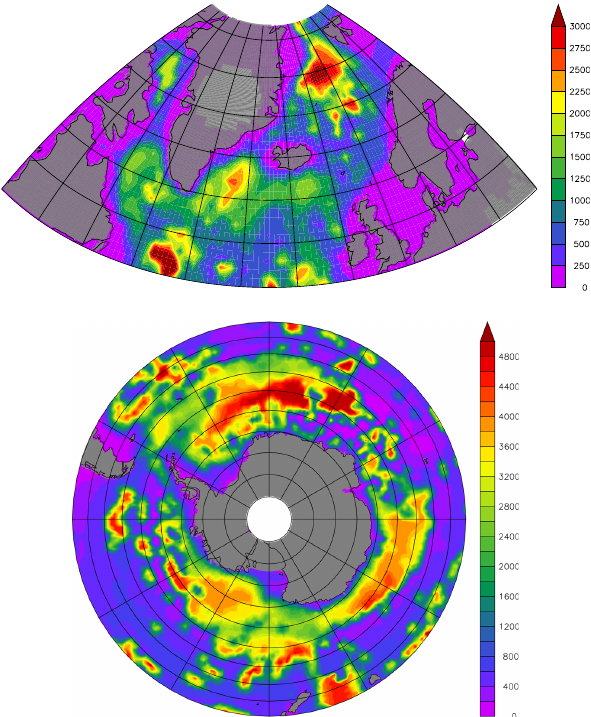
Fig. 12. Maximum depth (m) of vertical convection for the years 1900–1999 of simulation TRANS.